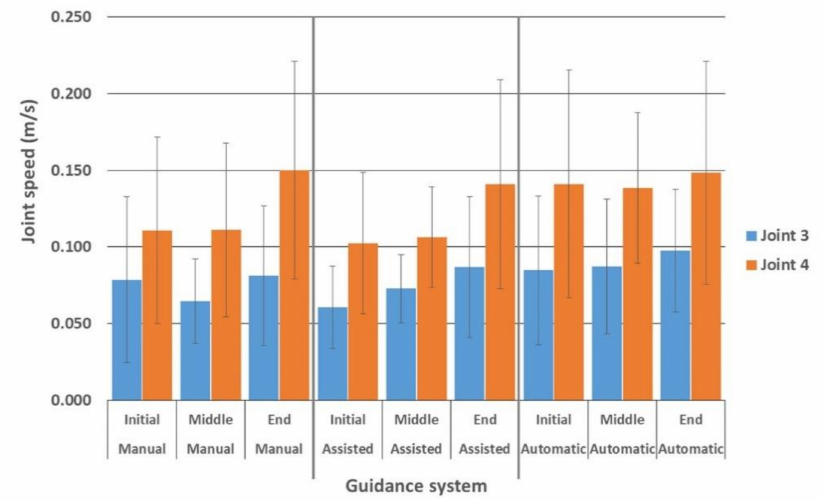
Figure 8. Speed values measured at the beginning, during, and at the end of the field tests carried out using the three analyzed guidance systems. Letters (a, b and A, B) refer to Tukey’s test on the two